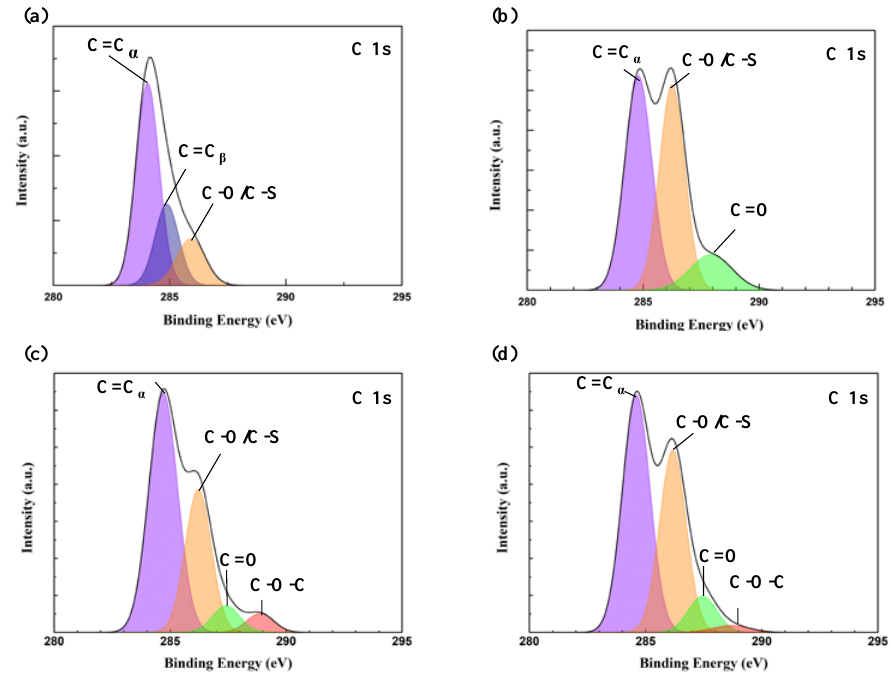
Figure 1. C (1s) peak of XPS spectra for ( a ) PEDOT: PSS, ( b ) PEDOT: PSS–sorbitol, ( c ) PEDOT: PSS–maltitol, and ( d ) PEDOT: